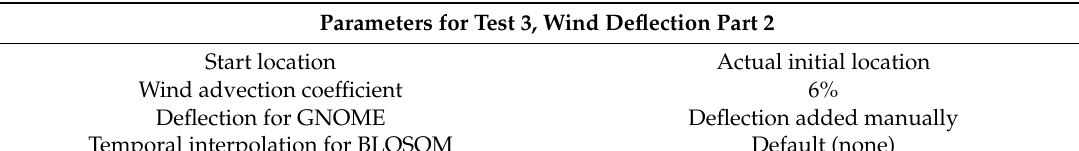
Table 6. Parameters for test 3, wind deflection part 2.